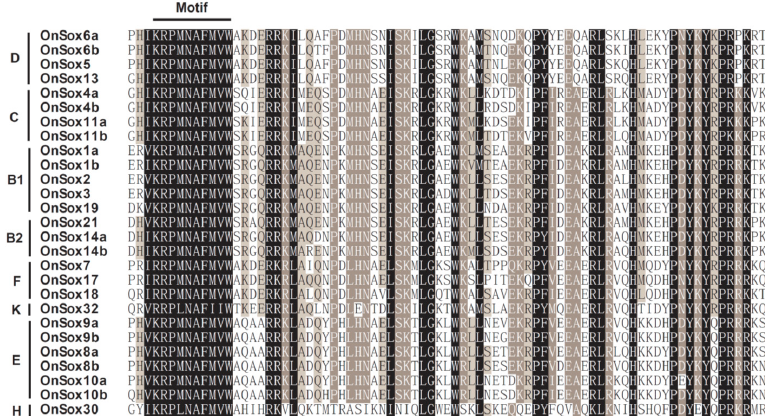
Figure 2. Multiple alignment of HMG-box domain sequences of the tilapia Sox proteins. The Multiple alignment of HMG-box domain sequences of the tilapia Sox proteins. HMG-box domain of each Sox protein was predicted online using SMART program (http://smart.embl-heidelberg.de). ClustalX program was used to carry out a multiple alignment of amino acid sequences of the HMG-box domain of all the tilapia Sox proteins.